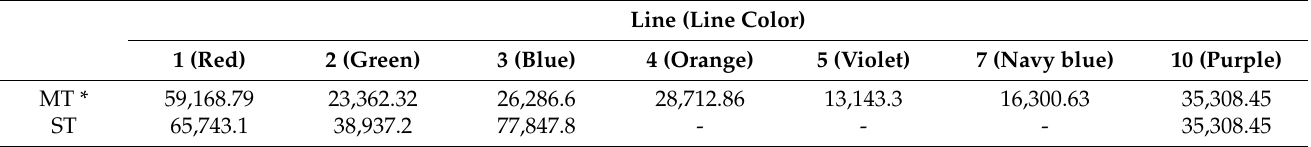
Table 6. Energy consumption of all lines in scenario 1 (kwh). Line (Line